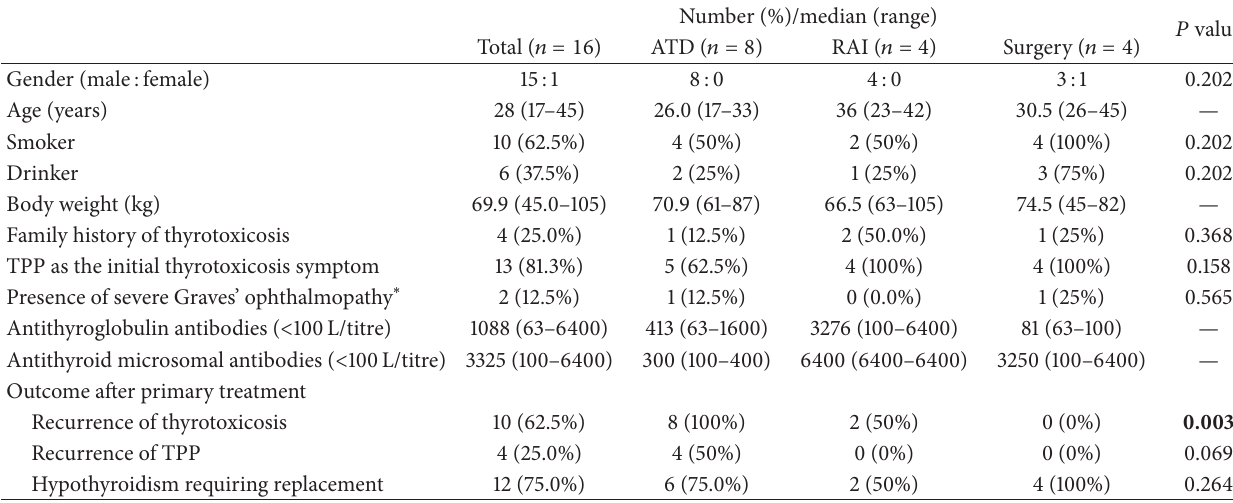
Table 1: A comparison of patient demographics and treatment outcome between patients who had antithyroid drugs (ATD), radioactive iodine (RAI), and surgery as the primary treatment for Graves’ disease with thyrotoxic periodic paralysis (TPP).